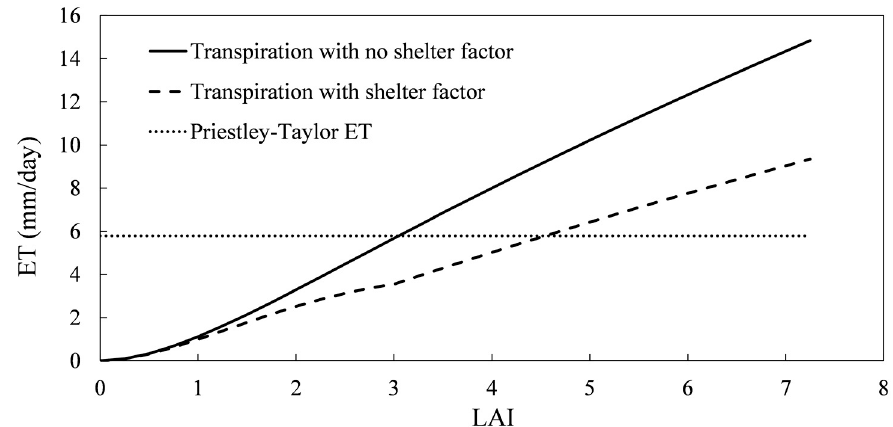
Figure 3. Variations in total ET with LAI with and without the shelter factor ( f s ) to limit transpiration component of ET for a select location along with potential Priestley–Taylor ET (30 degrees latitude, 100 m elevation, closed shrublands land cover, albedo of 0.19, daily minimum maximum temperatures of 15 °C and 30 °C, time of year is mid-July).